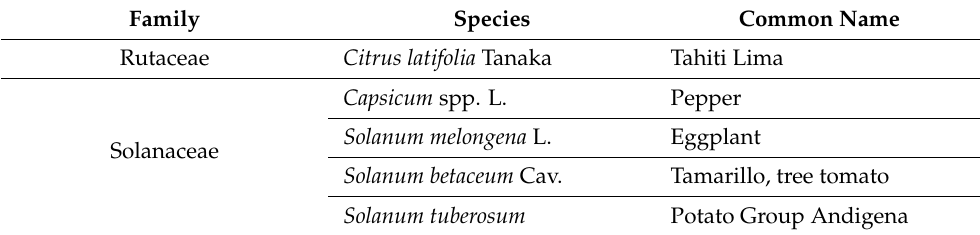
Table 2. Cont. Family